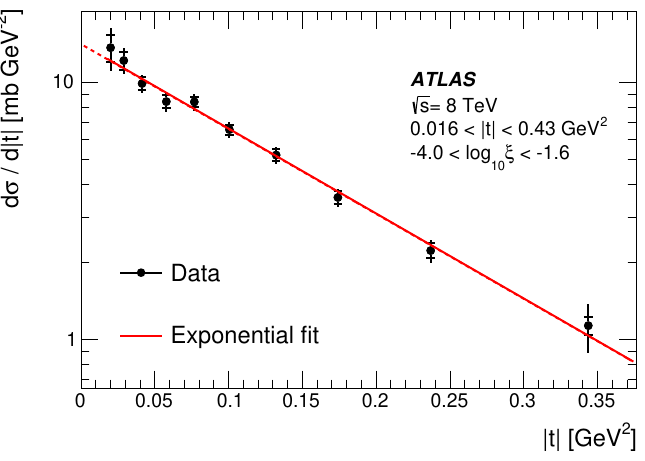
Figure 4. The di(cid:11)erential cross section as a function of j t j with inner error bars representing statistical uncertainties and outer error bars displaying the statistical and systematic uncertainties added in quadrature. The result of the exponential (cid:12)t described in the text is